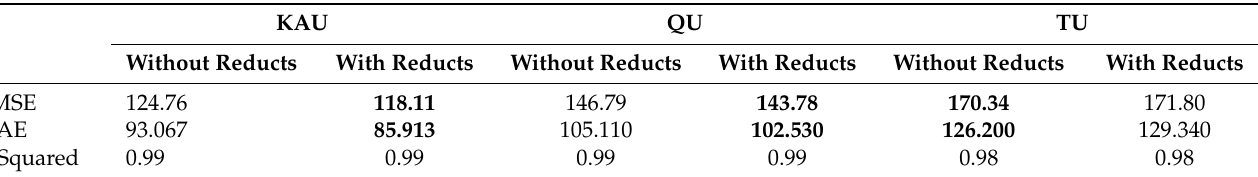
Figure 15. The predicted solar irradiance versus the real values for TU dataset with reduction. Table 9. Root Mean Square Error (RMSE), Mean Absolute Error (MAE) and R-Squared of GHI Values (in W/m 2 ) using regression prediction models on KAU, QU and TU